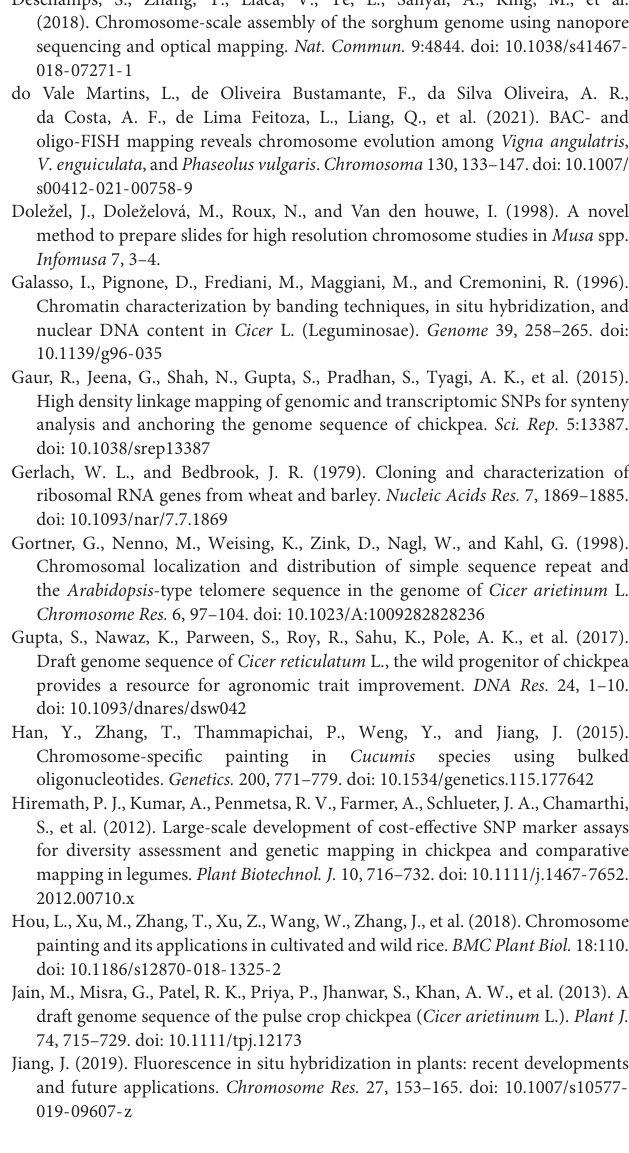
Supplementary Figure 2 | Integration of oligopainting probe CAF-OP1 (green) and CAF-OP2 (red) with the extant cytogenetics landmarks (yellow) on mitotic metaphase chromosomes of C. arietinum CDC Frontier (kabuli): (A) 5S rDNA; (B) BAC 05E03; (C) telomeric sequence [TTTAGGG] n ; (D) BAC 14M02; (E) 45S rDNA; (F) BAC 10I13; and (G) BAC 11K07, on mitotic metaphase chromosomes of C. arietinum CDC Frontier (kabuli). Chromosomes were counterstained with DAPI (blue). Arrows indicate positions of BAC clones or rRNA probes. Bar = 3 µ m. Supplementary Figure 3 | Integration of oligopainting probe CAF-OP1 (green) and CAF-OP2 (red) with the extant cytogenetics landmarks (yellow) on mitotic metaphase plates of C. arietinum ICC 1882 (desi): (A) 5S rDNA; (B) BAC 11K07; (C) 45S rDNA; (D) BAC 10I13; and (F) BAC 5E03 (yellow). (E) Localization of oligopainting probe CAF-OP1 (green) with telomeric sequence (red) and BAC 10I13. (G) Colocalization of oligopainting probe CAF-OP1 (green) with telomeric sequence (red) and BAC 14M02 (yellow). Chromosomes were counterstained with DAPI (blue). Arrows indicate positions of BAC clones or rRNA